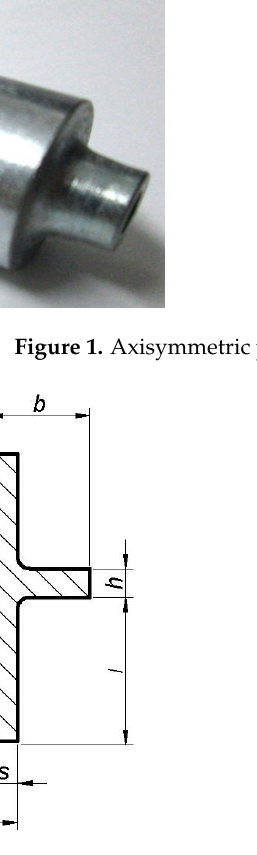
Figure 2. Sketch of the Flange part.